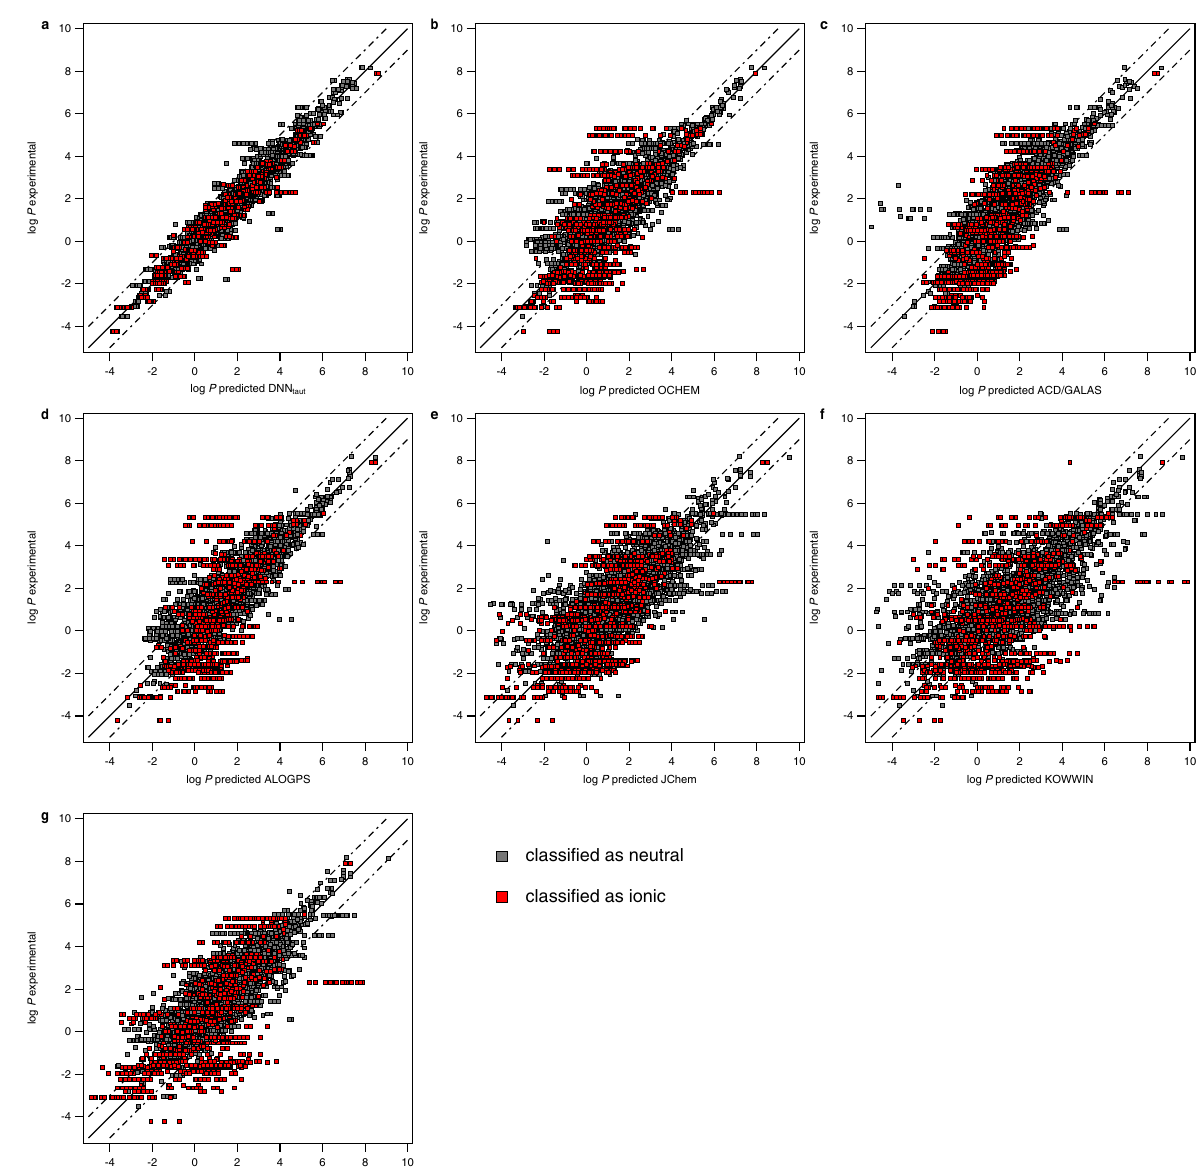
Fig. 2 Predictions of log P values for the test set by our DNN taut and six selected tools. The structure representation of the test set chemicals include all SMILES codes (initial, canonical, with explicit Hs) and the SMILES codes of all tautomers (multiple datapoints per chemical in case of tautomers). Neutral chemicals are marked in gray, potential ions, are marked in red. The predictions of log P values for the test set chemicals based on original SMILES and randomly selected SMILES (including tautomers) are shown in Supplementary Figs. 1, 2. The predictions are based on ( a ) our developed model DNN taut , or performed with tools from literature, namely ( b ) OCHEM, ( c ) ACD/GALAS, ( d ) ALOGPS, ( e ) JChem, ( f ) KOWWIN, and ( g )